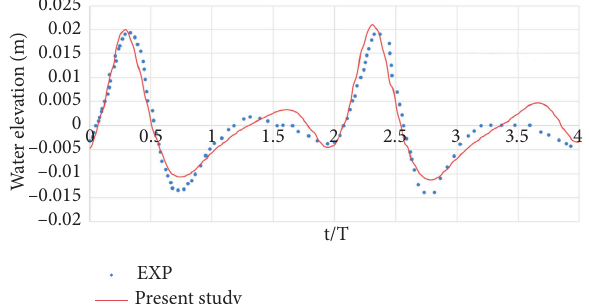
Figure 7: Water surface elevation at x � 17 .